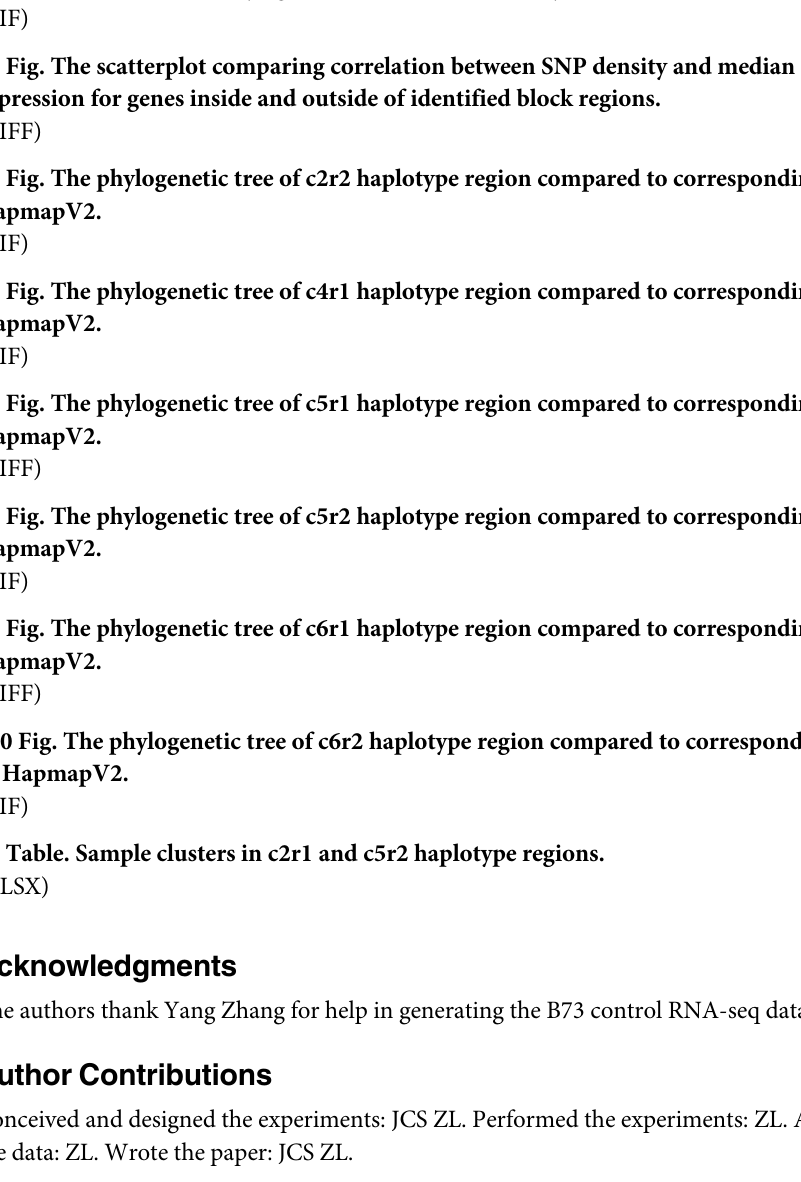
S1 Fig. The 7 named haplotype blocks and SNP distribution pattern across all 10 chromo- somes of maize for each of the 27 data sets. S2 Fig. A version of Fig 1A drawn as an unrooted tree. S3 Fig. (A) The maximum likelihood phylogenetic tree of 27 data sets by imputed SNP set; (B) One most parsimonious phylogenetic tree of 27 data sets by imputed SNP set. S4 Fig. The scatterplot comparing correlation between SNP density and median gene expression for genes inside and outside of identified block regions. S5 Fig. The phylogenetic tree of c2r2 haplotype region compared to corresponding lines in HapmapV2. S6 Fig. The phylogenetic tree of c4r1 haplotype region compared to corresponding lines in HapmapV2. S7 Fig. The phylogenetic tree of c5r1 haplotype region compared to corresponding lines in HapmapV2. S8 Fig. The phylogenetic tree of c5r2 haplotype region compared to corresponding lines in HapmapV2. S9 Fig. The phylogenetic tree of c6r1 haplotype region compared to corresponding lines in HapmapV2. S10 Fig. The phylogenetic tree of c6r2 haplotype region compared to corresponding lines in HapmapV2. S1 Table. Sample clusters in c2r1 and c5r2 haplotype regions.